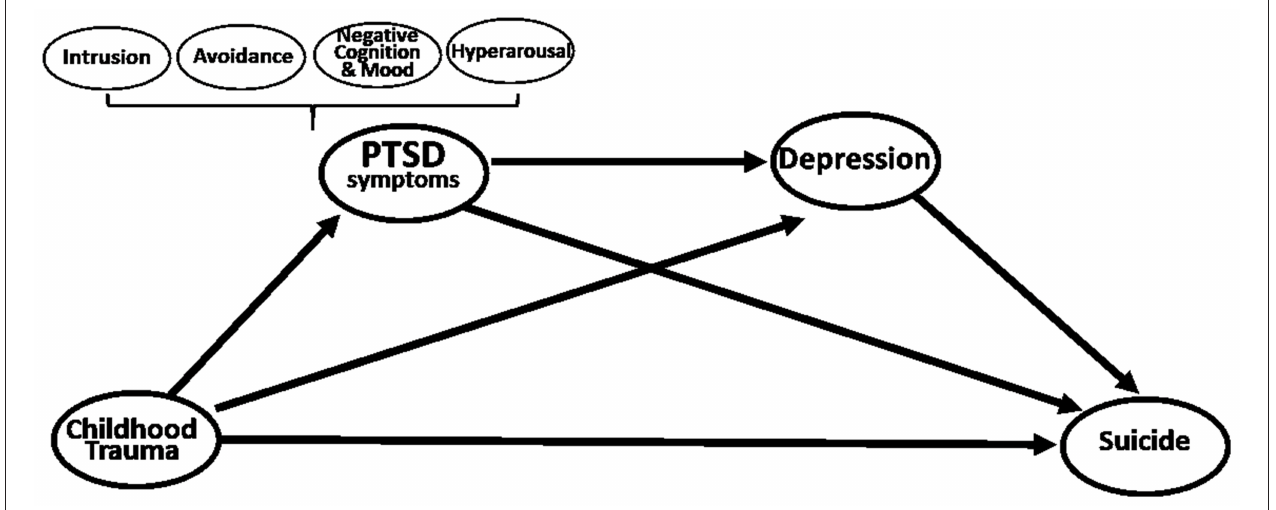
FIGURE 1 | Hypothetical model: Multiple mediation model for effect of childhood trauma on suicide via PTSD symptoms and